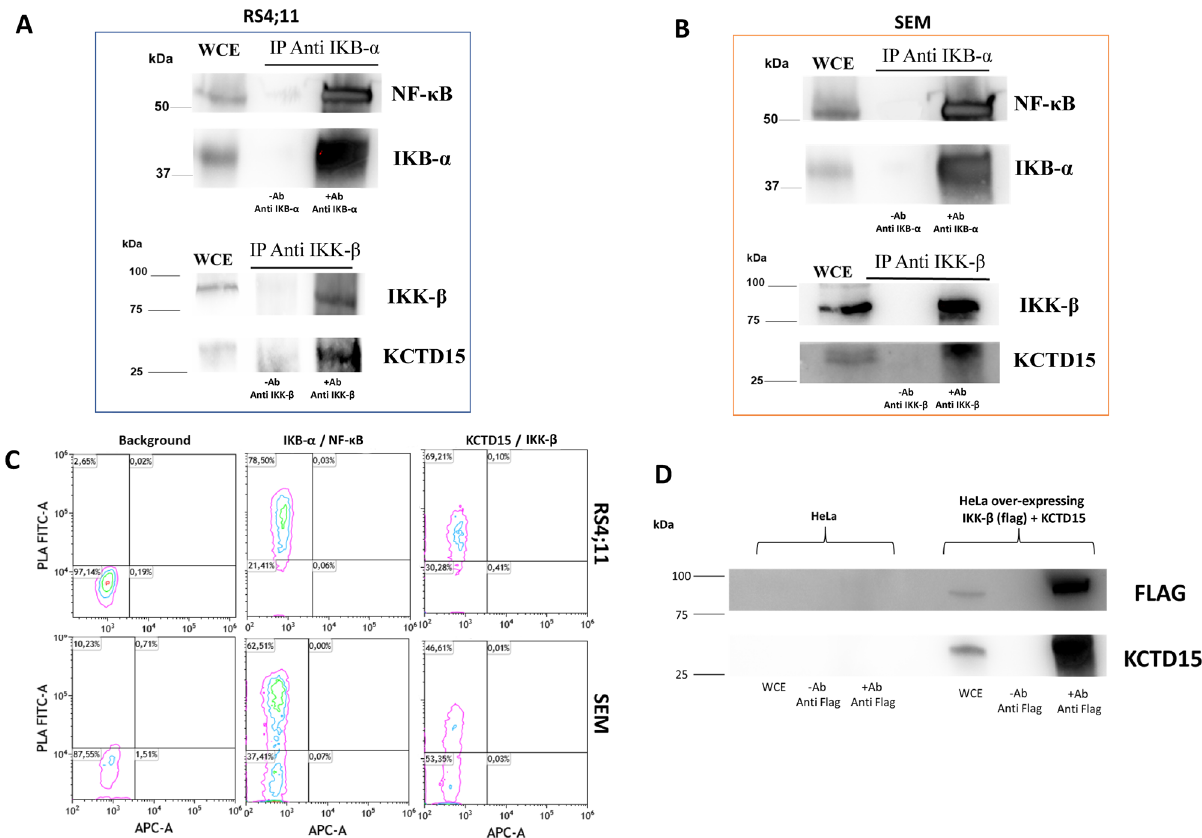
Figure 7. KCTD15 could be a novel interactor of IKK-β. RS4;11 ( A ) and SEM ( B ) cell extracts were incubated with antibody against IKK-β and IKB-α, precipitated by Protein A/G beads and detected by Western blots using a reported antibody. (+ Ab Anti #) = elution step in the presence of antibodies. (− Ab Anti #) = elution without antibody. WCE whole cell extract. The number represents the molecular weight of the protein marker expressed in kDa. ( C ) PLA experiments were conducted on active growing RS4;11 and SEM cells. PLA signal associated with FITC fluorescence was recorded using a Cytoflex cytometer. Negative technical control (Background column) was obtained using the Anti KCTD15 antibody and the two PLA probes. Numbers show the percentage of positive cells with respect to the negative control. Experiments were repeated twice with similar results. ( D ) HeLa over-expressing FLAG-IKK-β and KCTD15 cell extracts were incubated with anti-FLAG antibody, precipitated by Protein A/G beads, and detected by Western blots using the reported antibody. (+ Ab Anti #) = elution step in the presence of antibodies. (− Ab Anti #) = elution without antibody. WCE whole cell extract. The numbers represent the molecular weight of the protein marker expressed in